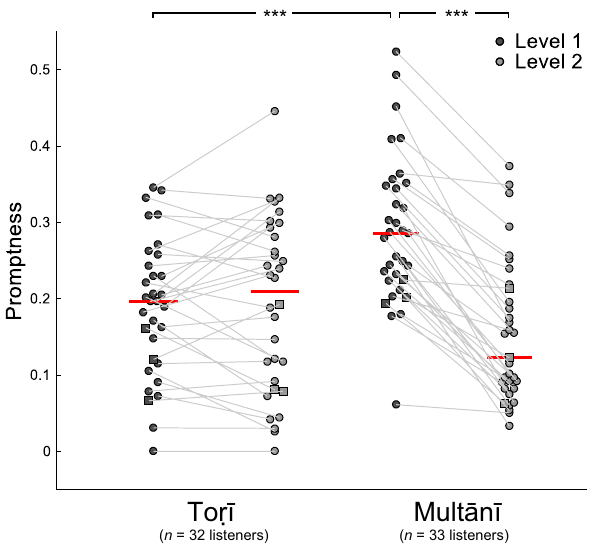
Figure 4. Promptness scores for Level 1 and 2 EDBRs, in each rāga. Dots represent individual participants’ promptness scores, averaged across listenings, cumulated across hits and normalised by the corresponding number of EDBRs in each case. Squares represent participants familiar with Indian music ( n = 3 in each